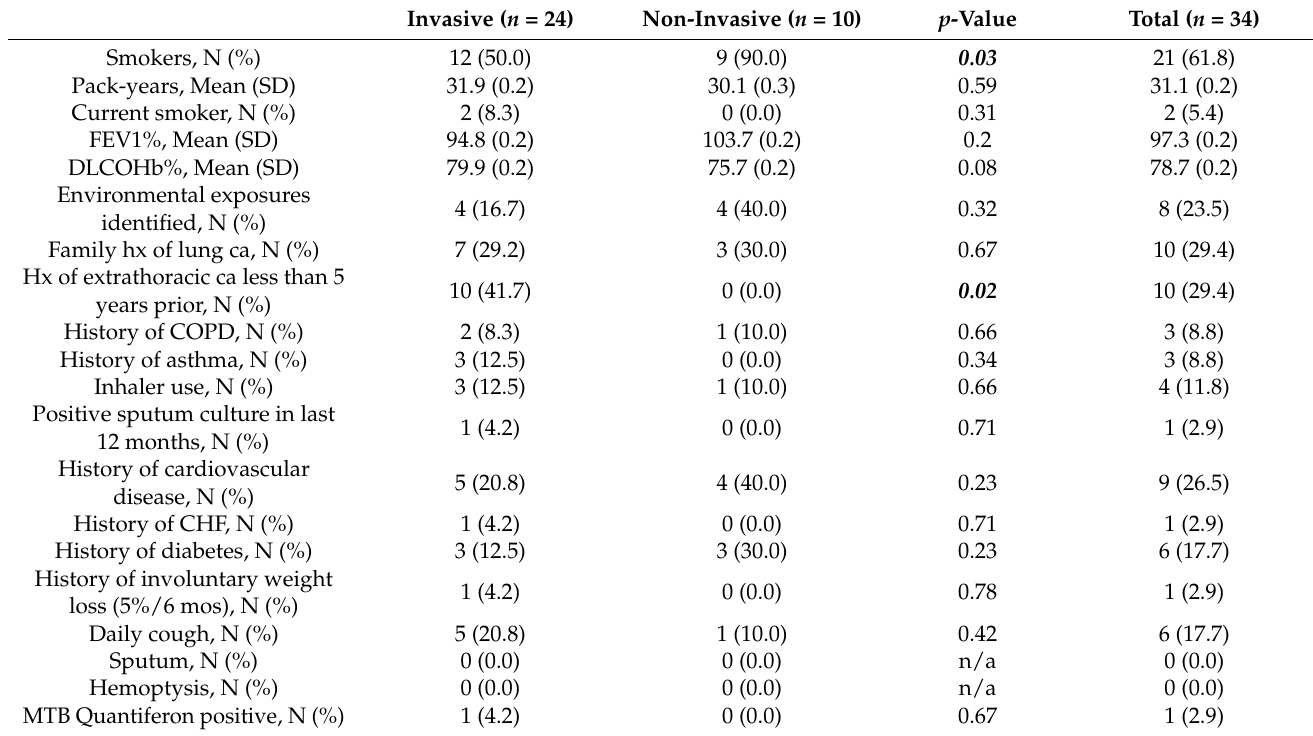
Table 2. Clinical factors associated with invasiveness.